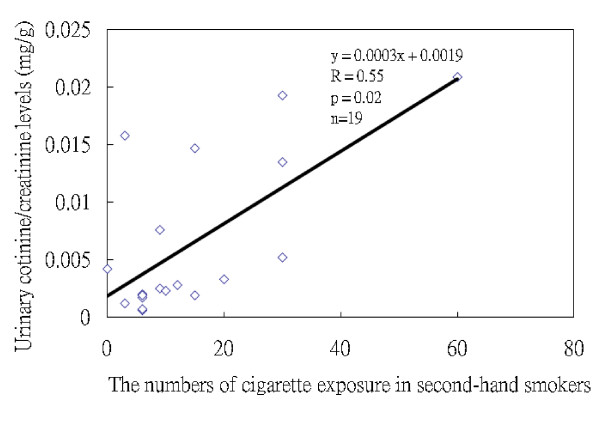
Correlation between the urinary cotinine levels (mg/g creatinine) and the number of cigarettes they reported themselves as being exposed to SHS during the 3 days leading up to the collection of urine specimens. (Spearman correlation coefficients, r = 0.55, p = 0.02, n = 19)